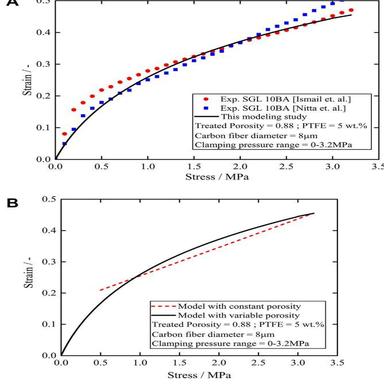
(a) Comparison of statistically predicted and measured stressestrain curves and (b) comparison of predicted mechanical deformation characteristics with and without local variation of the PTL porosity.